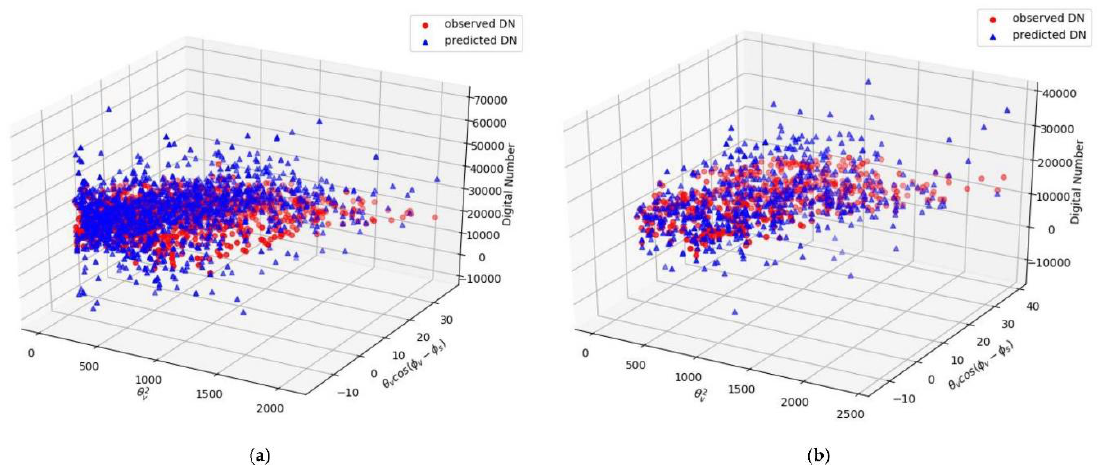
Figure 8. The diagrams show the predicted nadir DN versus observed DN by solving tie points' Walthal bidirectional reflectance distribution function (BRDF) coefficients for the avocado image, ( a ) shows the scatterplot for canopy tie points, ( b ) shows the scatterplot for ground tie points. The x -axis represents squared viewing zenith angle, and the y -axis represents the viewing zenith angle multiply by the cosine of solar-viewing azimuth angle difference.